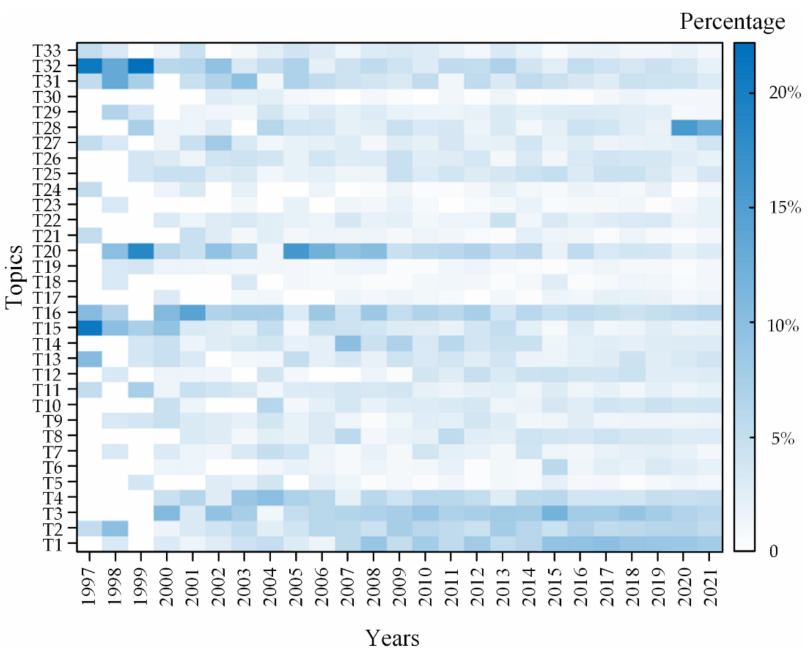
Figure 6. Heat map of the keywords over the